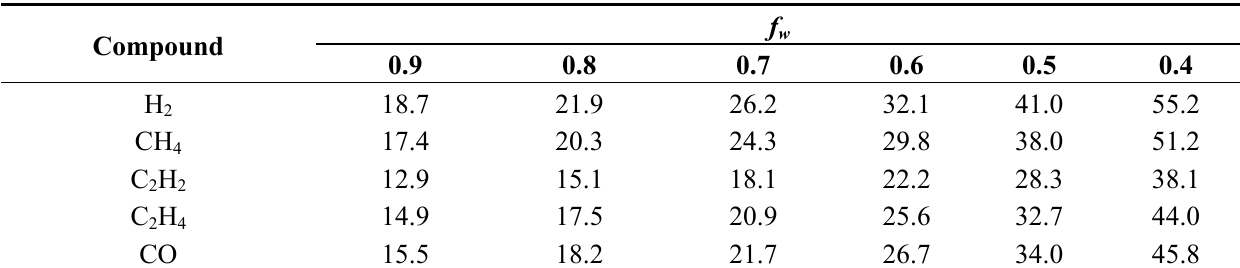
Table 5. Values of the parameter η (m) calculated for different positively/neutral buoyant gases and satisfying the condition .